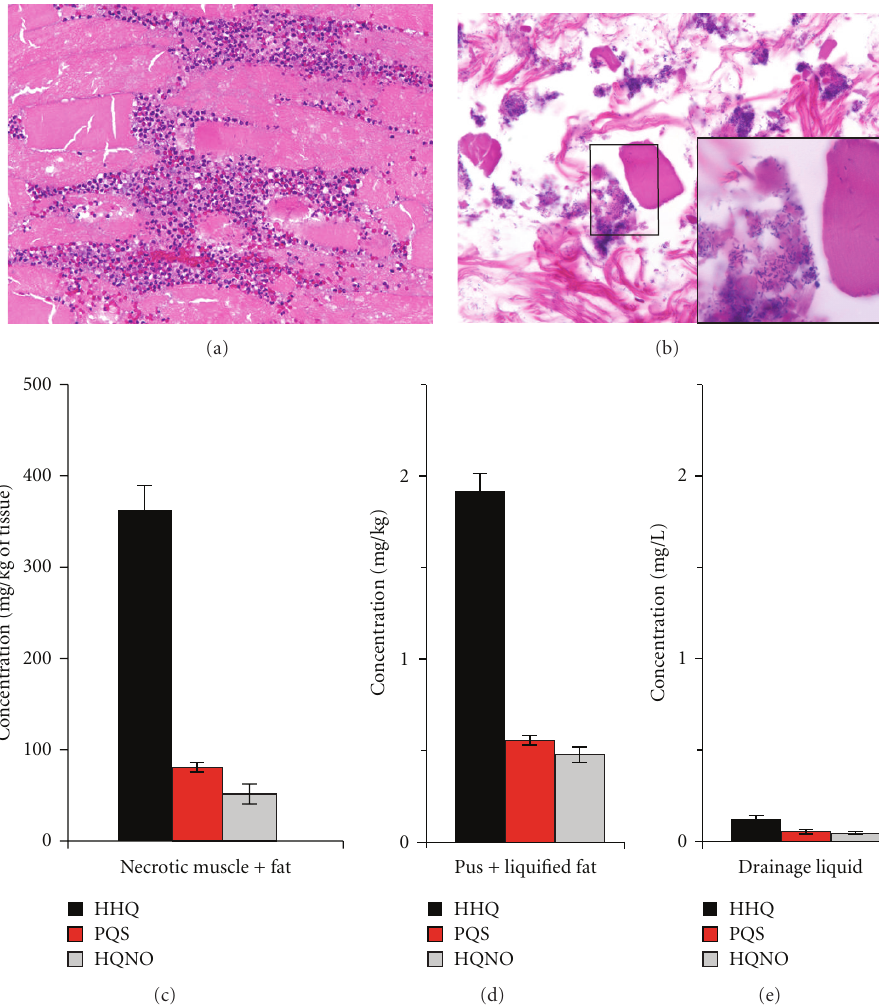
Figure 1: High levels of HAQs are produced in P. aeruginosa infected burn wounds. (a) Hematoxylin and eosin stained sections of right lower extremity biopsy specimen demonstrating active deep infection with myonecrosis and inflammatory infiltrate (10x) (b) Oil immersion view of the same specimen demonstrating myonecrosis with proliferating rods. Note the presence of intramuscular bacteria (inset). HHQ, PQS and HQNO levels measured in two operative specimens, necrotic muscle with fat (c) and pus and liquefied fat (d); and from the collected drainage liquid (e) obtained from an infected burn wound on the patient’s right leg. Notably, HAQs were detected in the drainage liquid at a magnitude similar to that encountered in bacterial broth